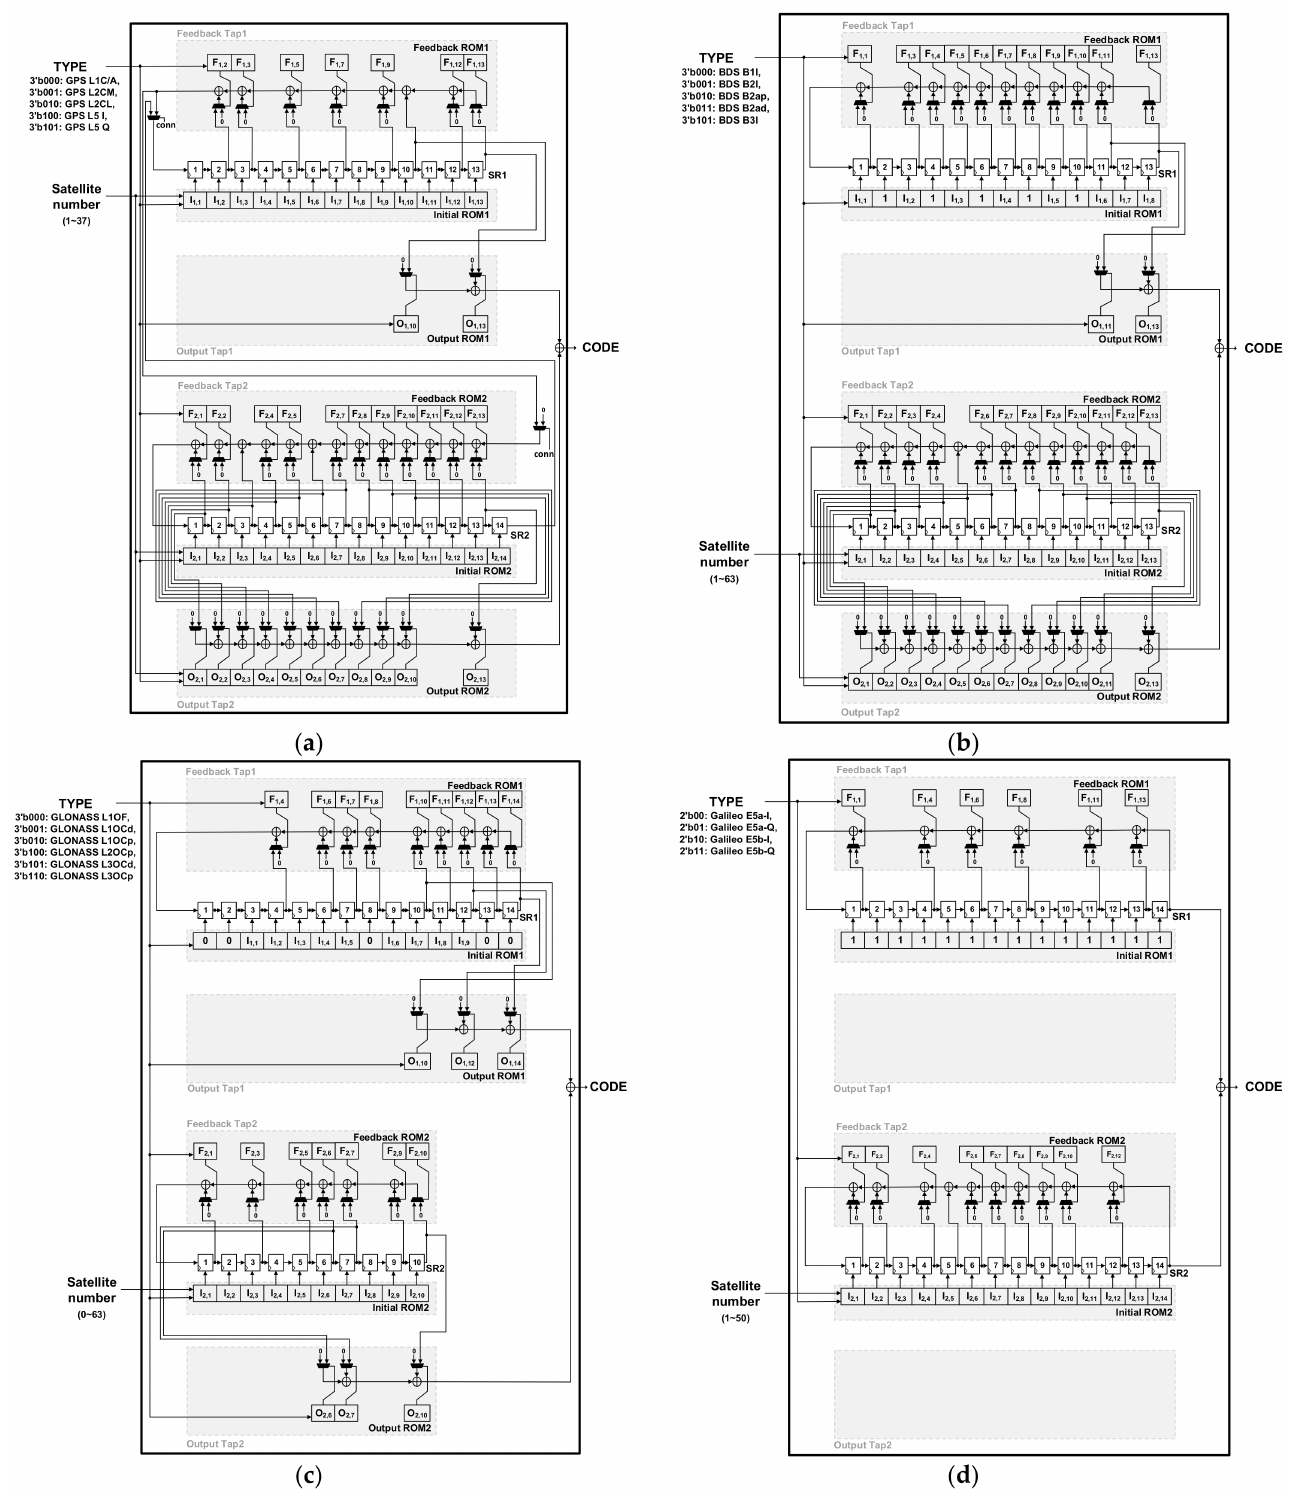
Figure 5. Proposed multi-frequency universal code generator architecture of each GNSS signal. ( a ) GPS. ( b ) BDS. ( c ) GLONASS. ( d )